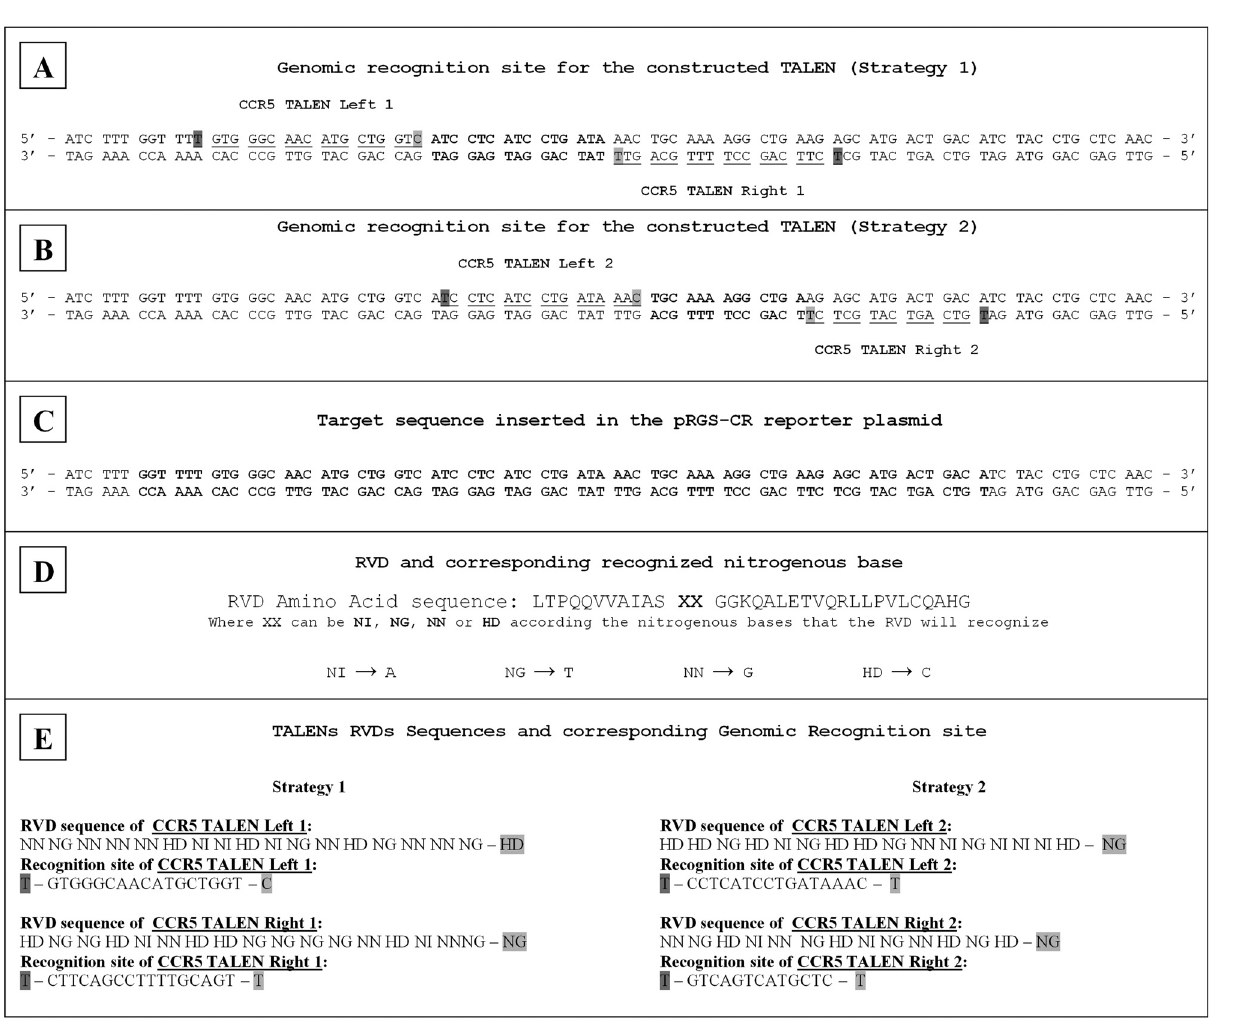
Figure 1 - TALEN genomic recognition sites and corresponding RVD sequences. (A) The underlined sequences represent the RVD recognition sites of the right and left subunits of CCR5 TALEN 1 proposed by Mussolino et al. (2011). (B) The underlined sequences represent the RVD recognition sites of therightandleftsubunitsofCCR5TALEN2proposedbyMiller etal. (2011)(AandB).Thenucleotidesinboldindicatethe“spacersite”forcleavageby FokI nuclease. The thymine highlighted in dark gray before the RVD recognition sites represents the first fixed nucleotide (thymine) targeted by any TALEN. The light gray highlighted nucleotide near the “spacer site” represents the nucleotide recognized by the last repeat RVD. (C) The nucleotides in bold represent the sequence inserted in the pRGS-CR reporter plasmid (Kim et al. , 2011) between RFP and GFP out of frame (see Figure 2 for more de- tails). (D) Amino acid sequence of RVD peptides and their respective targeted nucleotides. (E) RVD sequences and their corresponding target sites in the human genome. The RVD highlighted in light gray is the last repeat RVD, the nucleotide highlighted in light gray is that recognized by the last repeat RVD, and the thymine highlighted in dark gray is the first fixed nucleotide (thymine) targeted by any TALEN. This thymine is recognized by the TALEN arm but this TALEN site is not inserted in the TALEN assembly as a module, since it is already part of the TALEN backbone where it acts as a nuclear lo- calization signal